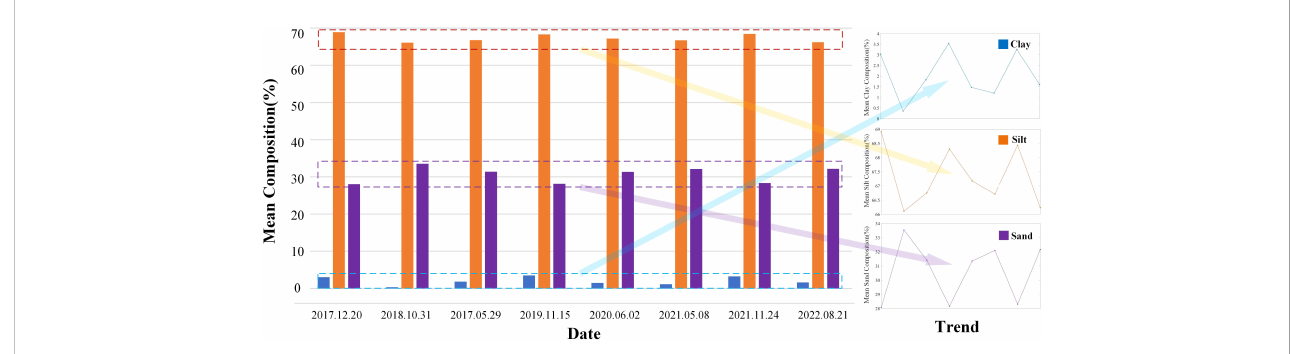
FIGURE 7 Evolution Trend of the Average Contents of Sediment Components in the Doulonggang Tidal Flat from 2017 to